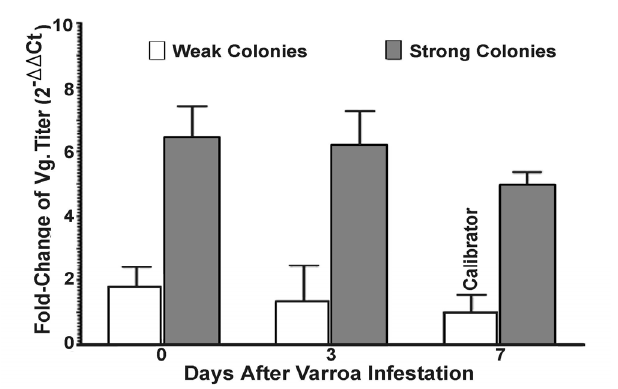
Figure 4. Relative quantitation of Vitellogenin (Vg) transcripts in bees from strong and weak colonies after Varroa mite